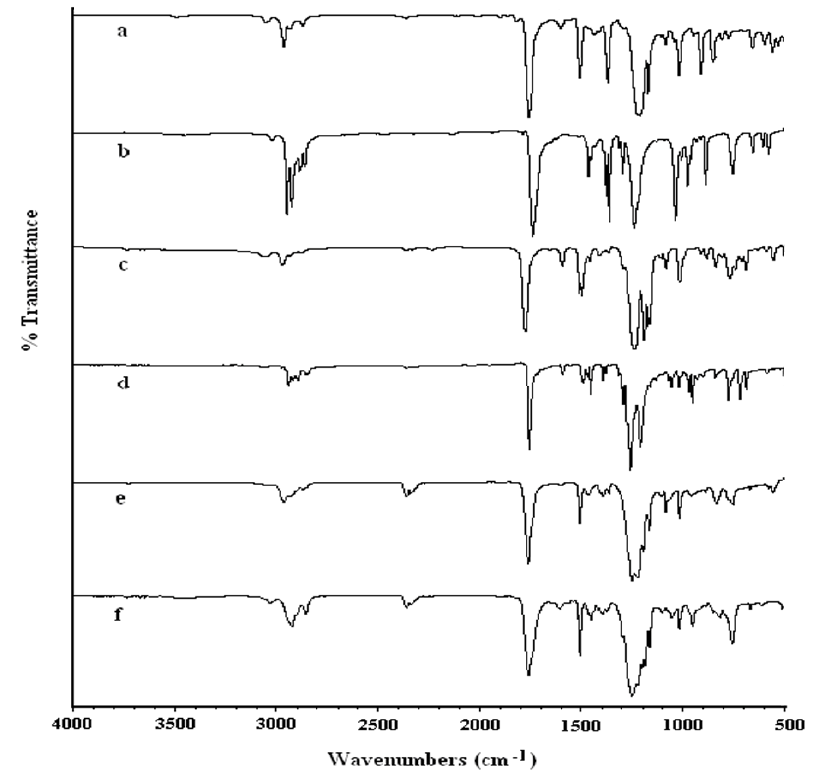
Figure 2. FTIR spectra of (a) BPA diacetate (b) CHDM diacetate (c) BPA DPDC (d) CHDM DPDC (e) BPA-PeD polycarbonate (f) CHDM-BHPM